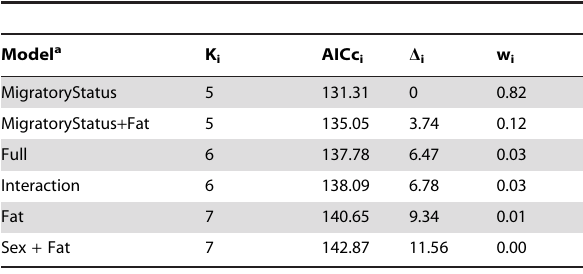
Table 2. Model selection results to predict plasma visfatin concentrations in the white-throated